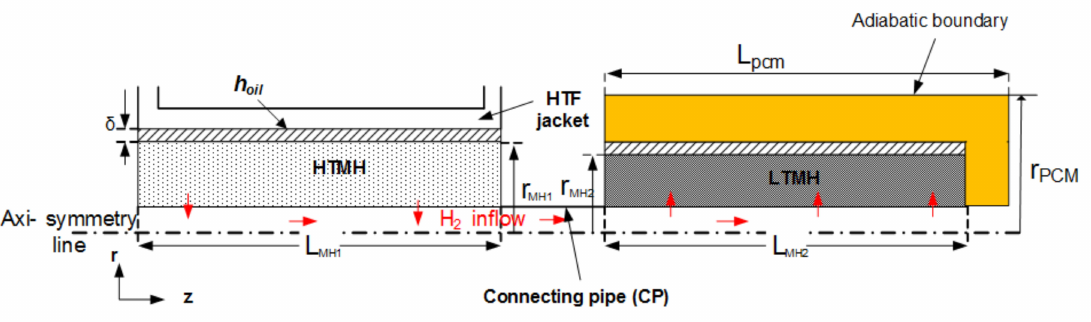
Figure 1. Axis-symmetry 2D computational volume.